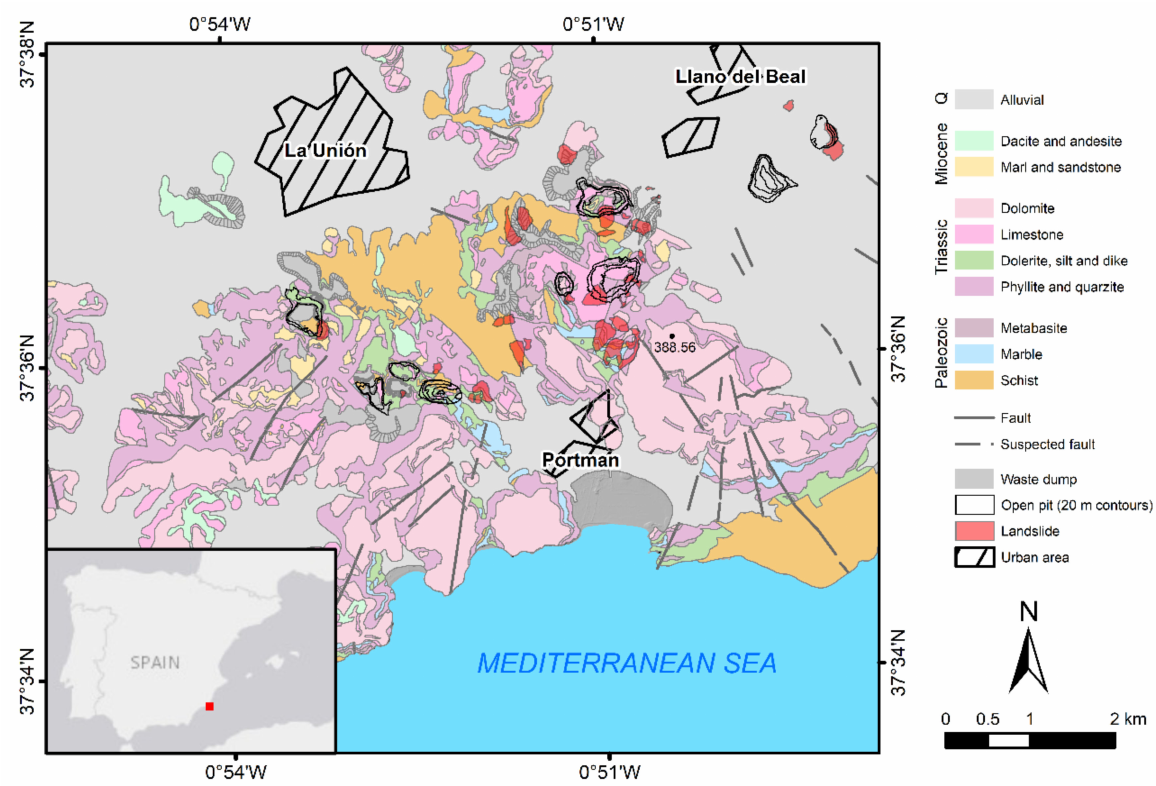
Figure 1. Study area and geological map of Sierra de Cartagena-La Uni ó n (adapted with permission from ref.